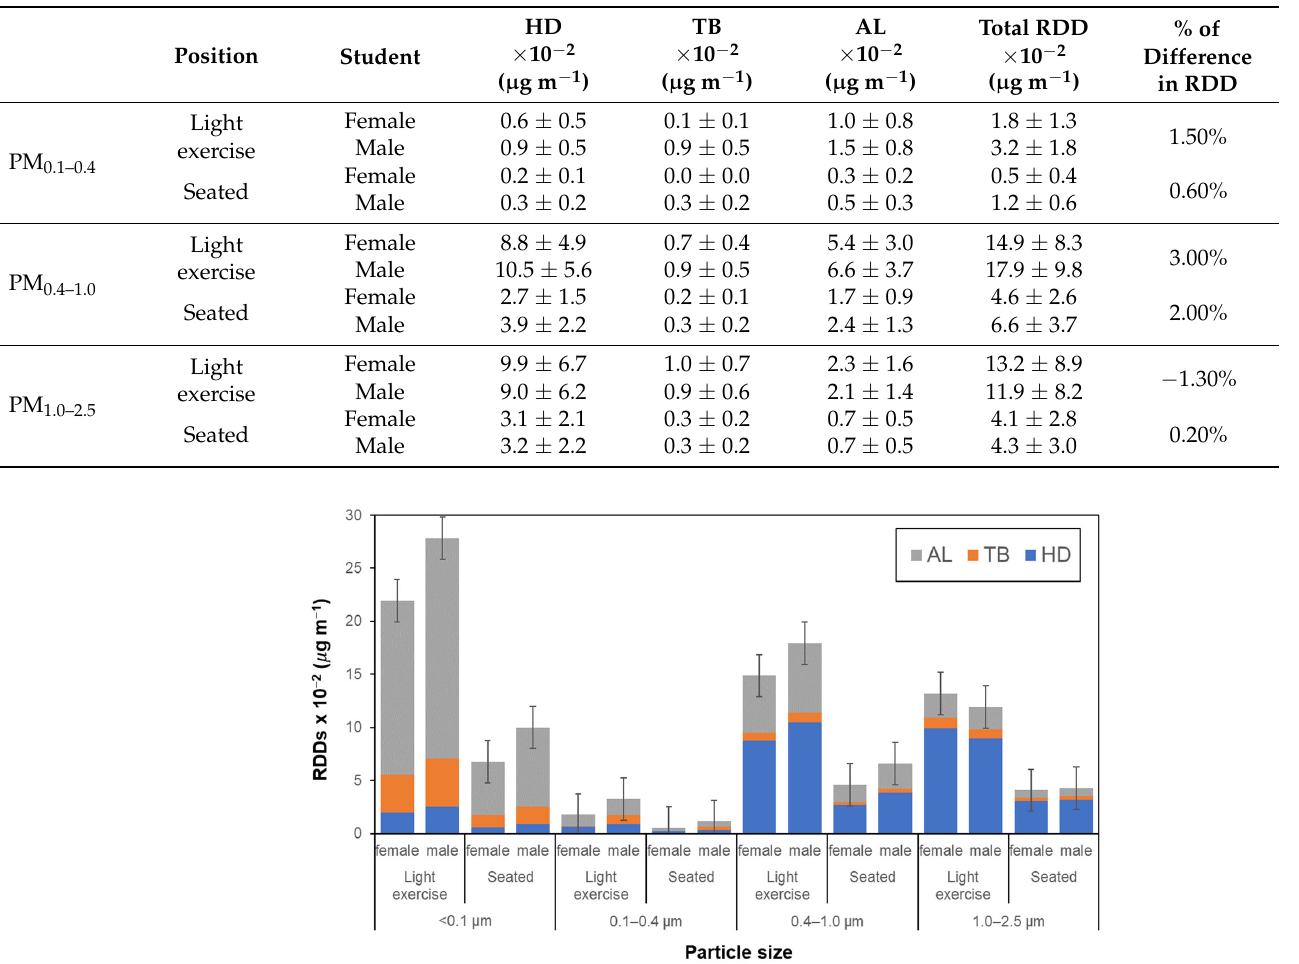
Figure 7. Respiratory deposition doses (RDDs) of PM 1.0–2.5 , PM 0.4–1.0 , PM 0.1–0.4 , and PM <0.1 particles in headways (HD), tracheobronchial (TB), and alveoli (AL) regions during light exercise and seated between female and male schoolchildren. Table 8. Descriptive characteristics while sitting or during light exercises and Mean ‐ difference (%) in RDD between the male and female students for different PM size stages. The mean ‐ difference value for RDD is calculated using male student’s RDD as a reference.